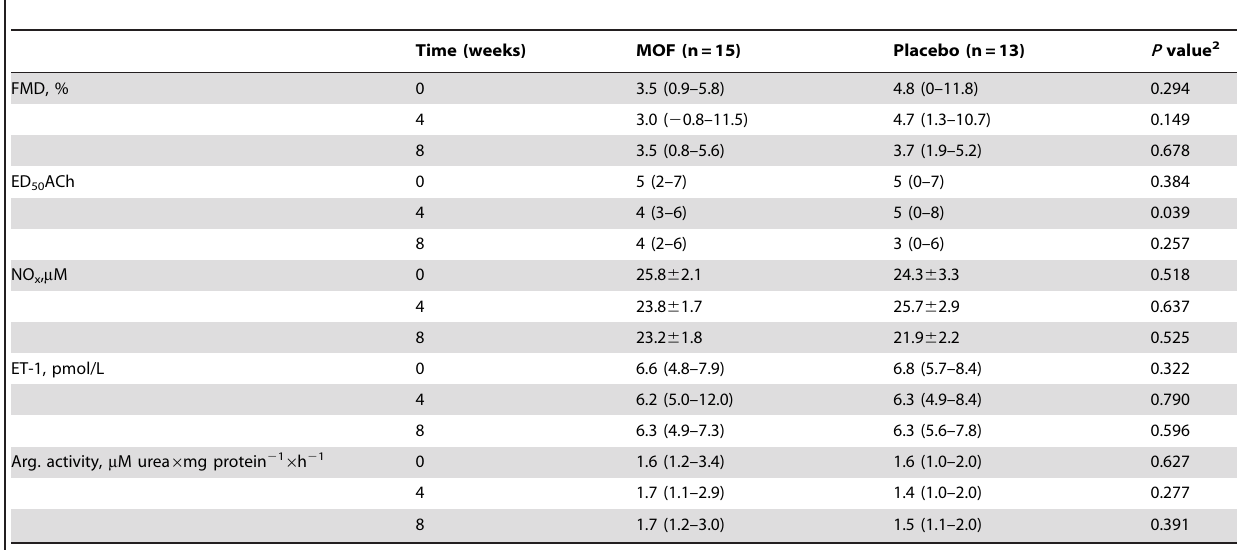
Table 4. Macro- and microvascular function and biochemical vascular parameters. 1